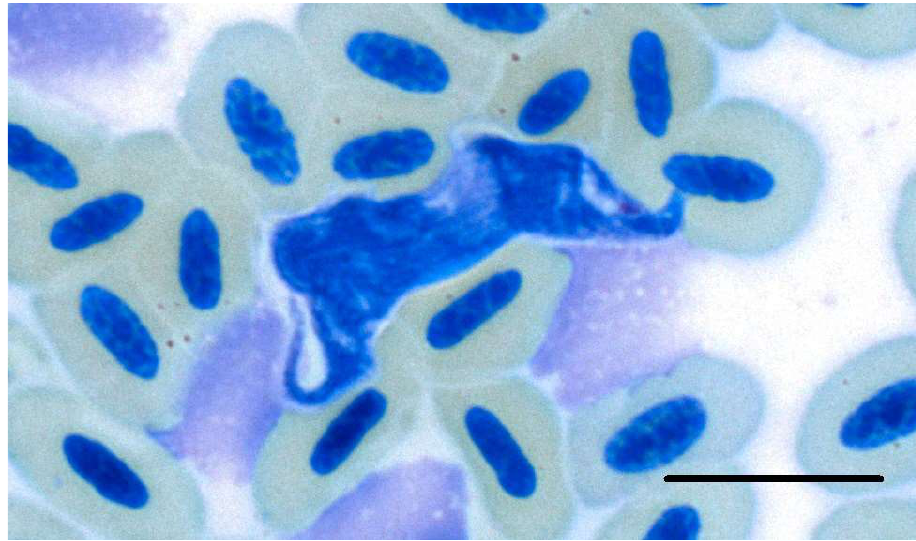
Figure 4. Trypomastigote form of Trypanosoma avium isolate CORVOID4 (OP006598) detected in a blood smear of Vanga curvirostris in Madagascar. Scale bar = 10 µm